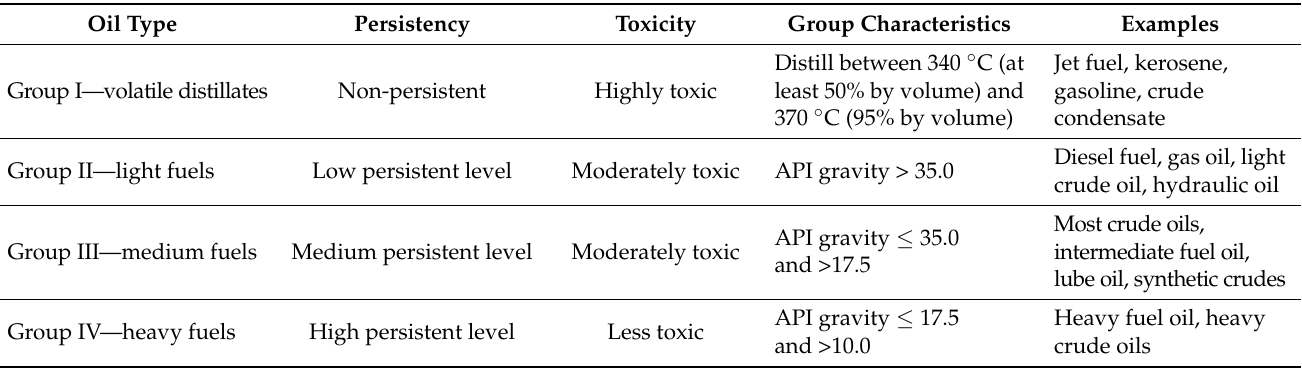
Table 2. Oil type classifications